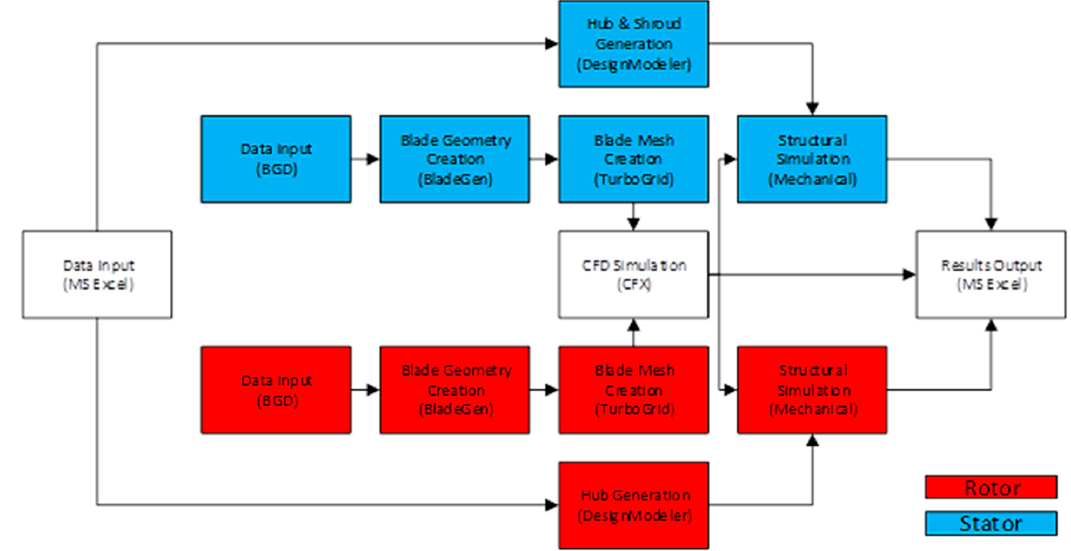
Figure 6. Schematic outlining the design evaluation process used in ANSYS Workbench 18.1.